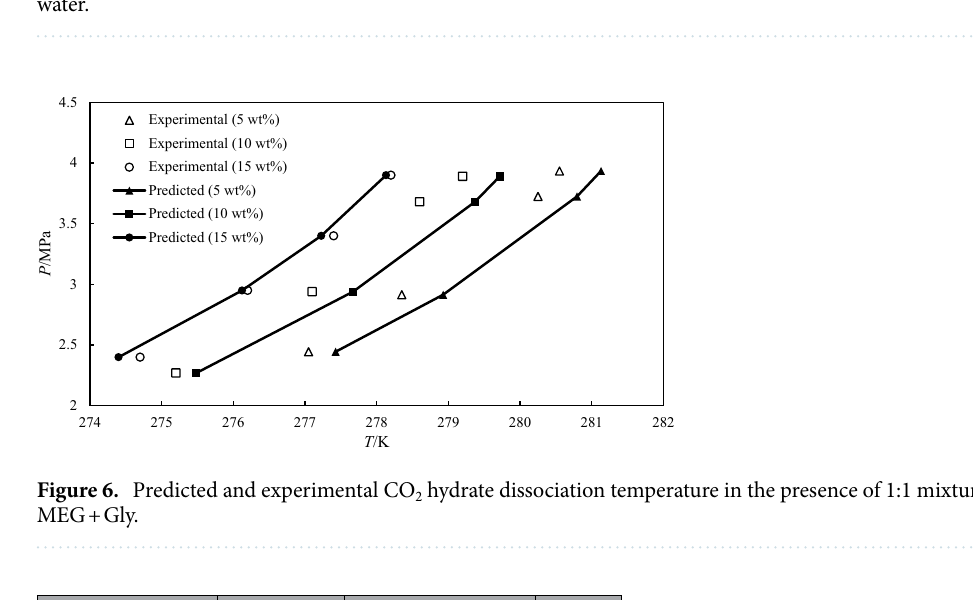
Sample No. data point Temperature range (K) AAE (K) MEG + Gly (5